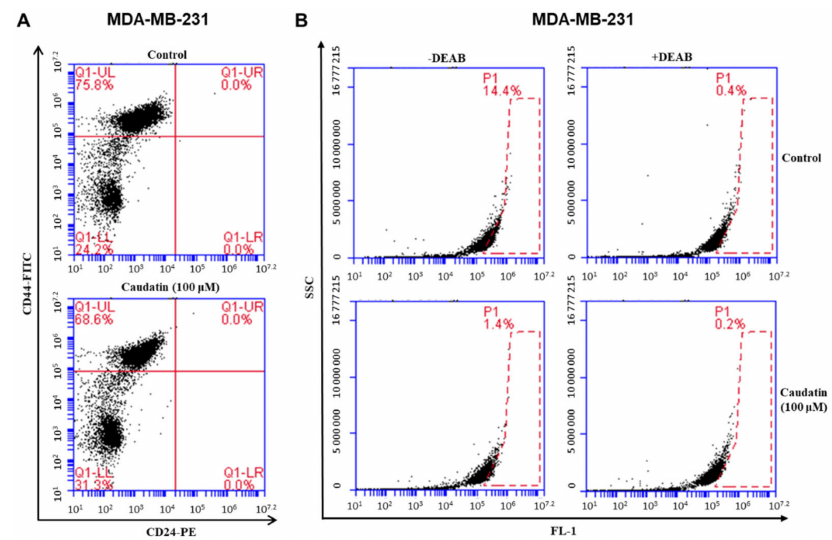
Figure 5. The e ff ects of caudatin on the CD44 high / CD24 low and aldehyde dehydrogenase (ALDH)-positive cell proportions in a breast cancer cell line. ( A ) The CD44 high / CD24 low cell population of MDA-MB-231 cells treated with caudatin (100 µ M) or DMSO for 24 h was analyzed by flow cytometry. The gating was based on the binding of a control antibody (red cross). ( B ) MDA-MB-231 cells were treated with caudatin (100 µ M) for 24 h and subjected to an ALDEFLUOR assay and FACS analysis. Representative flow cytometric data are shown. The right panel shows the ALDH-positive population treated with the ALDH inhibitor DEAB, and the left panel represents the ALDH-positive population without N,N-diethylaminobenzaldehyde (DEAB)